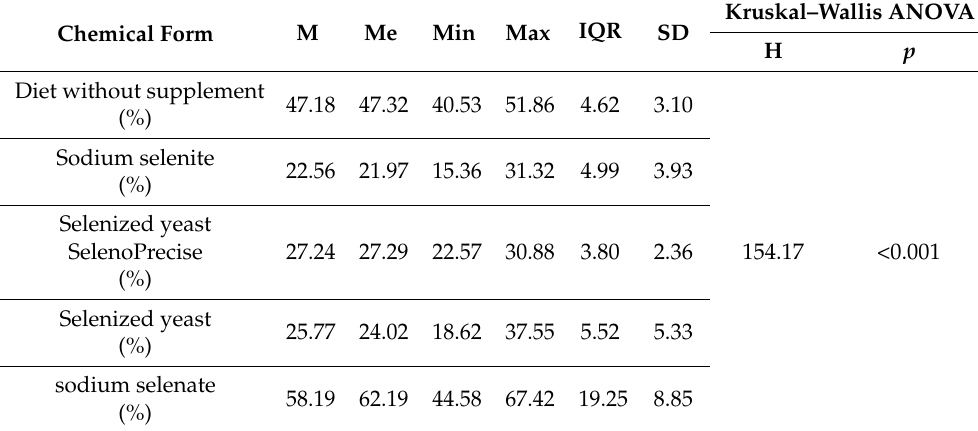
Table 5. Average bioavailability of Se considering chemical form. Chemical